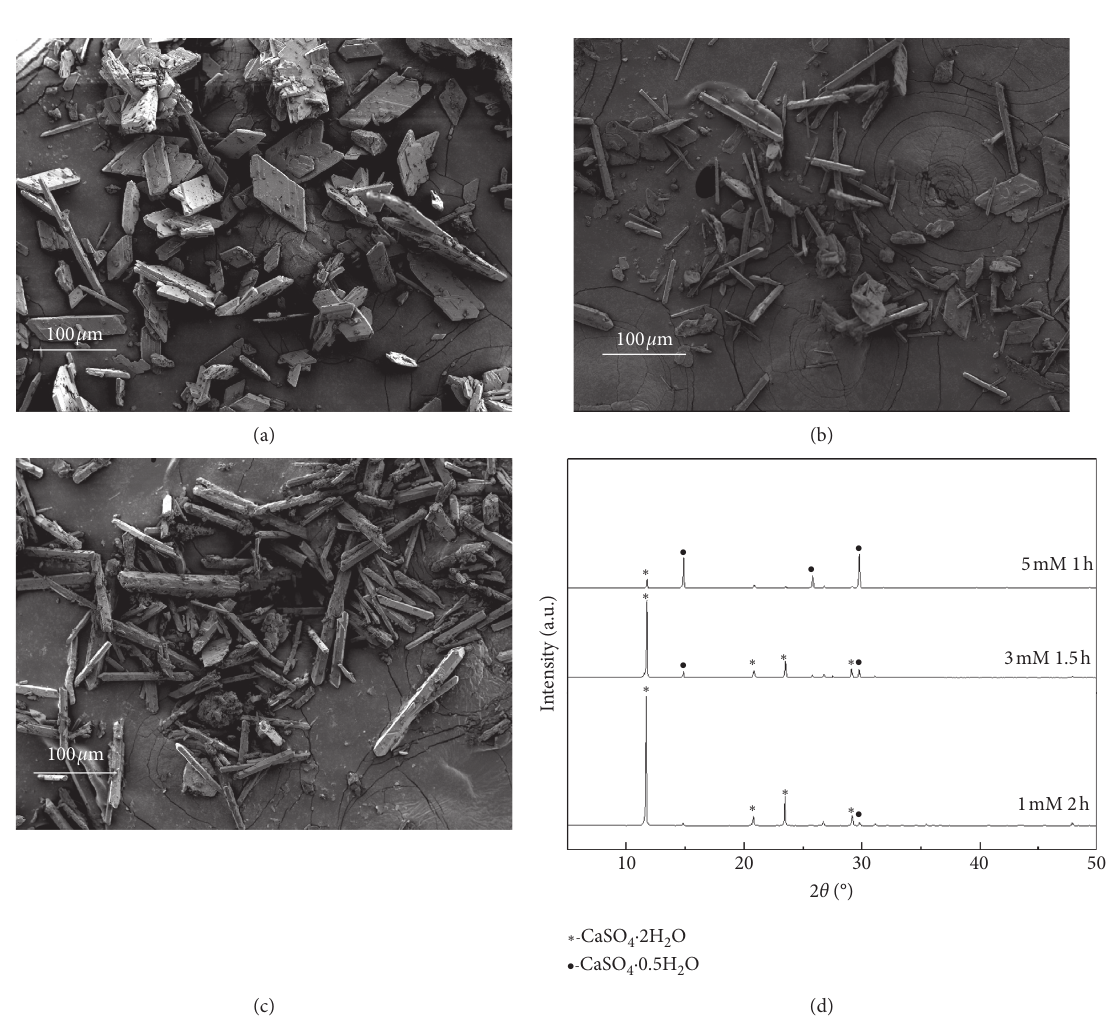
Figure 3: SEM photo (200 x ) taken at a heating temperature of 100 ° C when aluminum ion dosage and heating time were (a) 1 mM for 2 h; (b) 3 mM for 1.5 h; and (c) 5 mM for 1 h and the XRD pattern